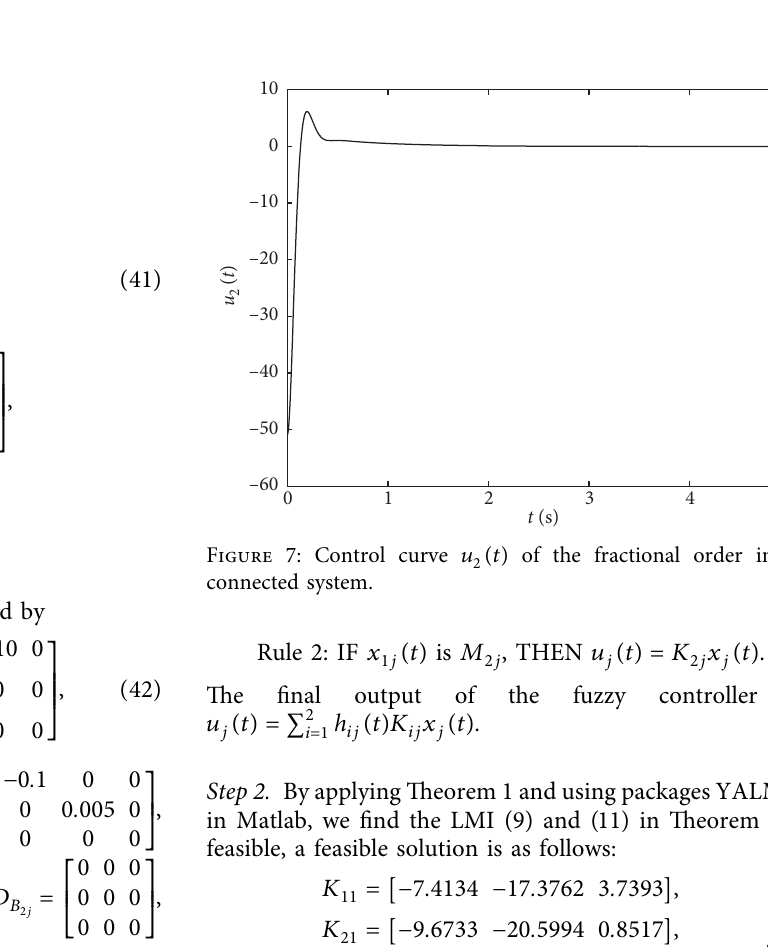
Figure 6: Control curve u connected system.